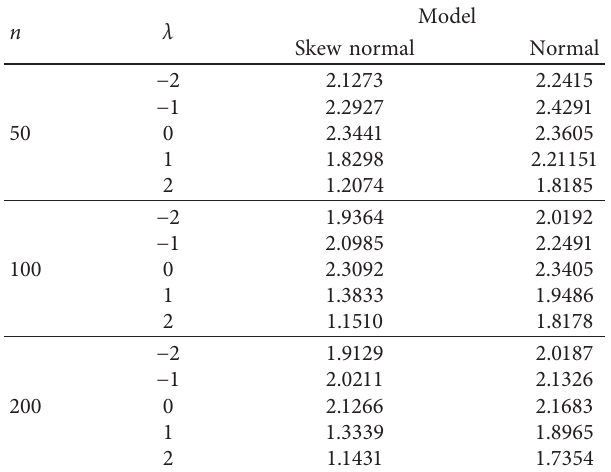
) from Model I and Model II. (b) Exact and estimated values of data from Model I and t Table 4: RMSE for different values of λ under the normal and SN ( x ) innovations, f 2